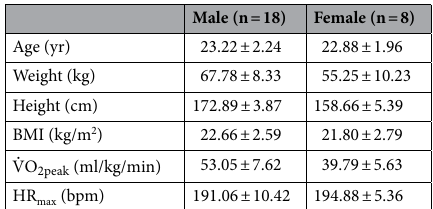
Table 2. The characteristics of participants (n = 26). Presented values are mean ± SD. BMI = Body Mass Index; ˙ VO 2peak = Peak oxygen uptake; HR max = Maximal Heart